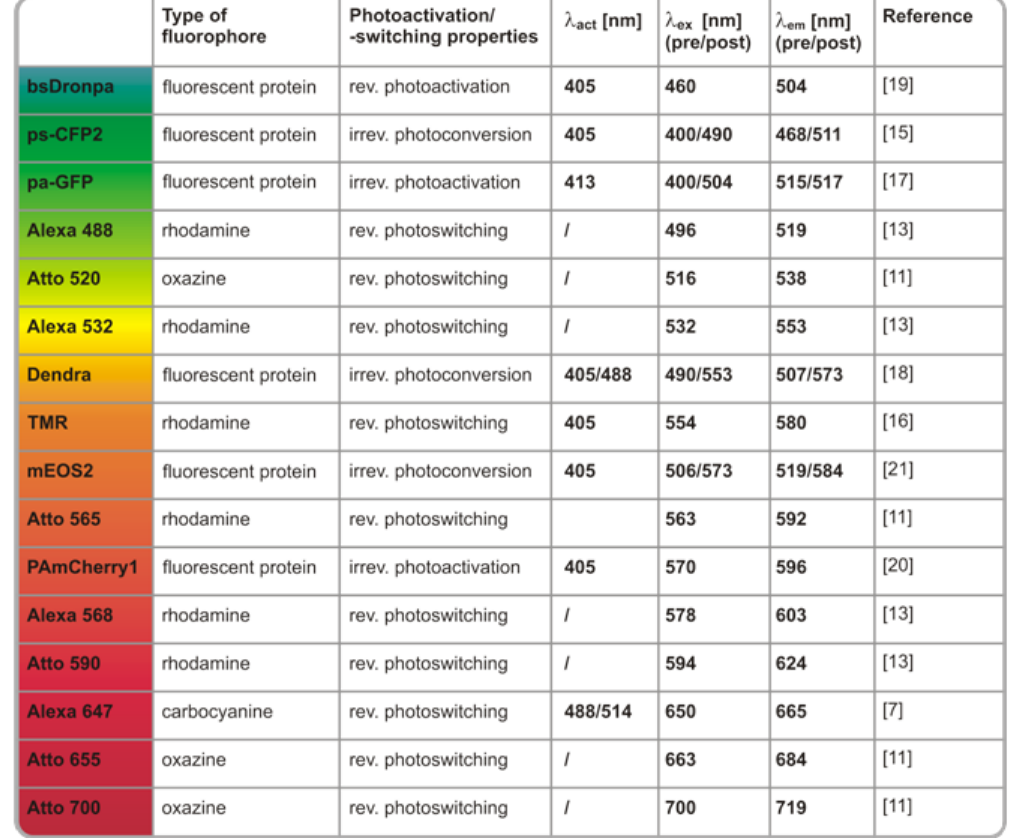
Table 1. A selection of fluorescent proteins and organic fluorophores that can be photoactivated or photoswitched and that are used in super-resolution